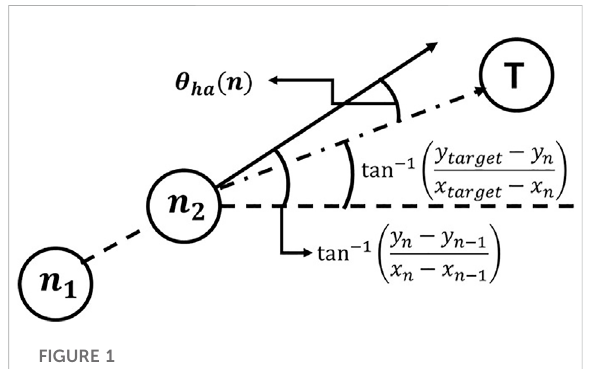
FIGURE 1 Schematic diagram for the heuristic